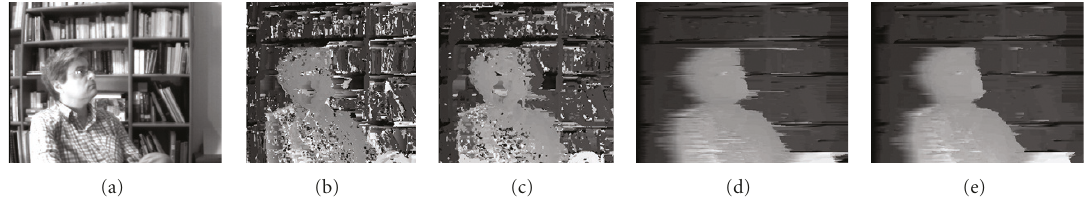
Figure 20: Processing of a real image with all types of processors: (a) right captured image, (b) processing with the plain SAD processor, (c) left-right consistency check with median filtering, and (d) plain DP processor (e) DP with interscanline support.